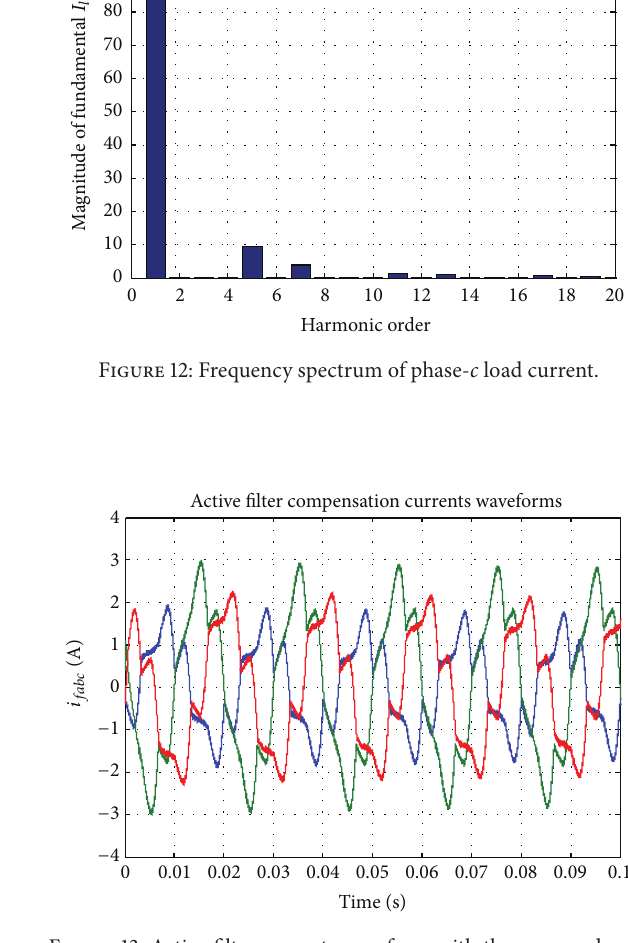
Table 2: The comparative results of THD.